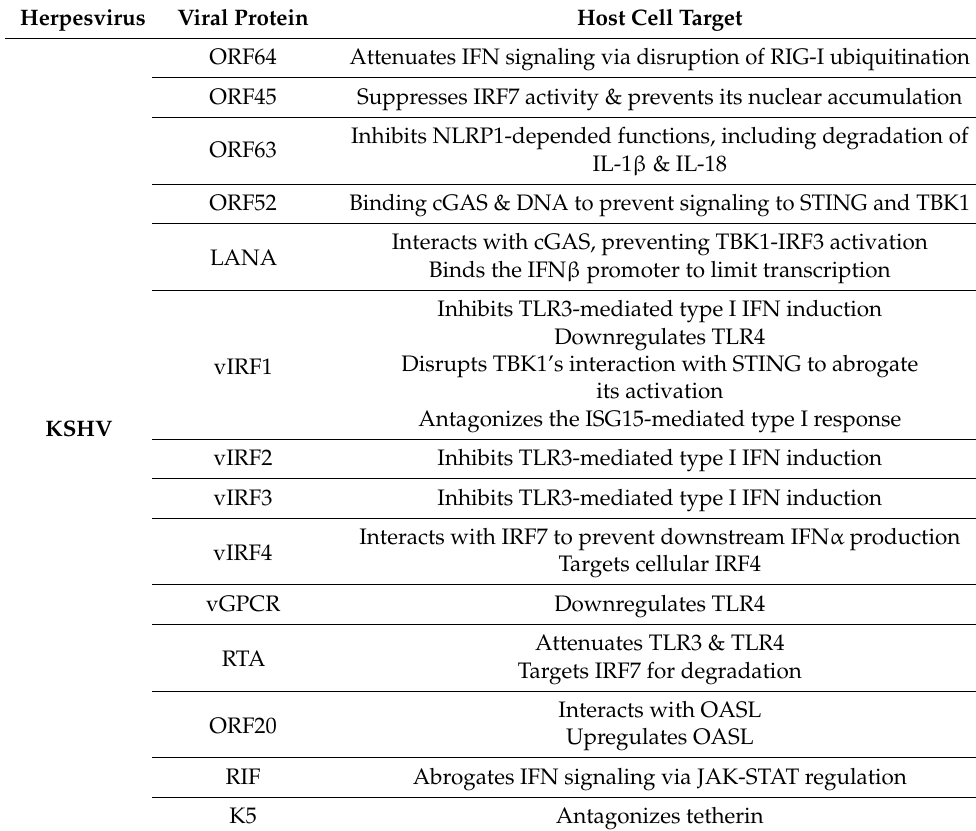
Table 3. KSHV employs multiple strategies to escape the innate immune